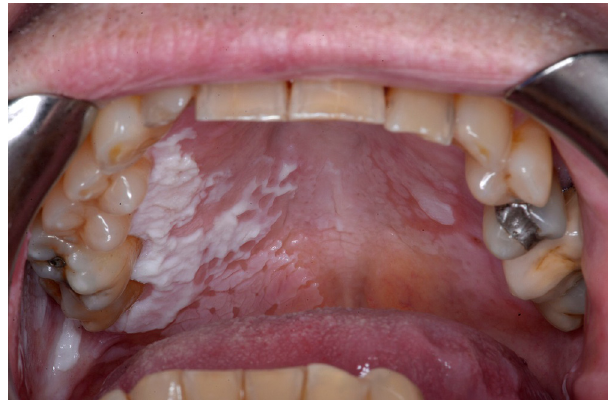
Fig. 3. Extensive verrucous leukoplakia involving the right palate and faint areas of leukoplakia involving the left palate (image provided by Guy ’ s and St Thomas